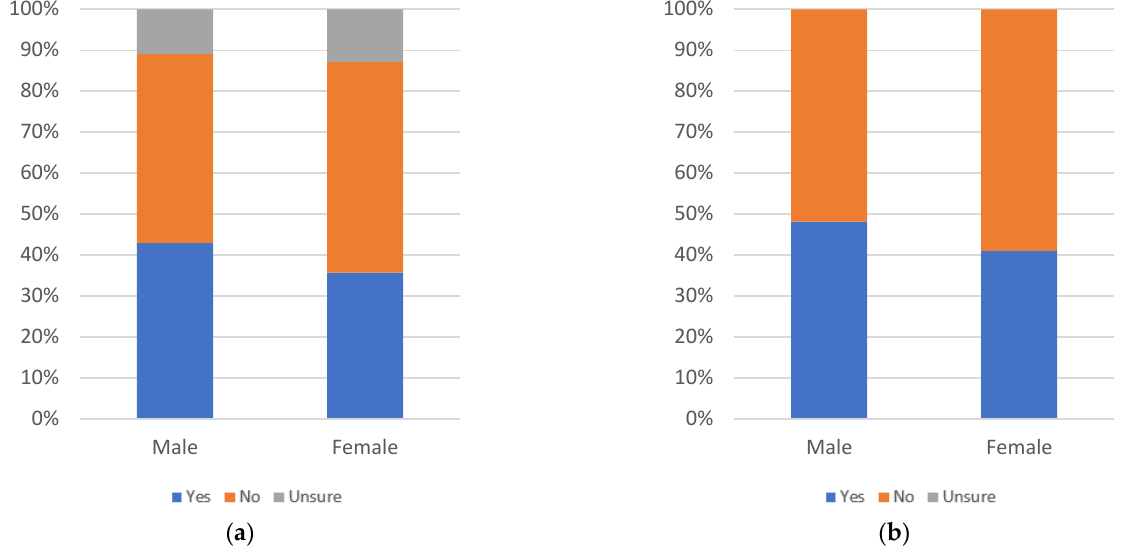
Figure 106. Label annoyingness, by gender: ( a ) with uncertain respondents (left) and ( b ) without uncertain respondents (right).